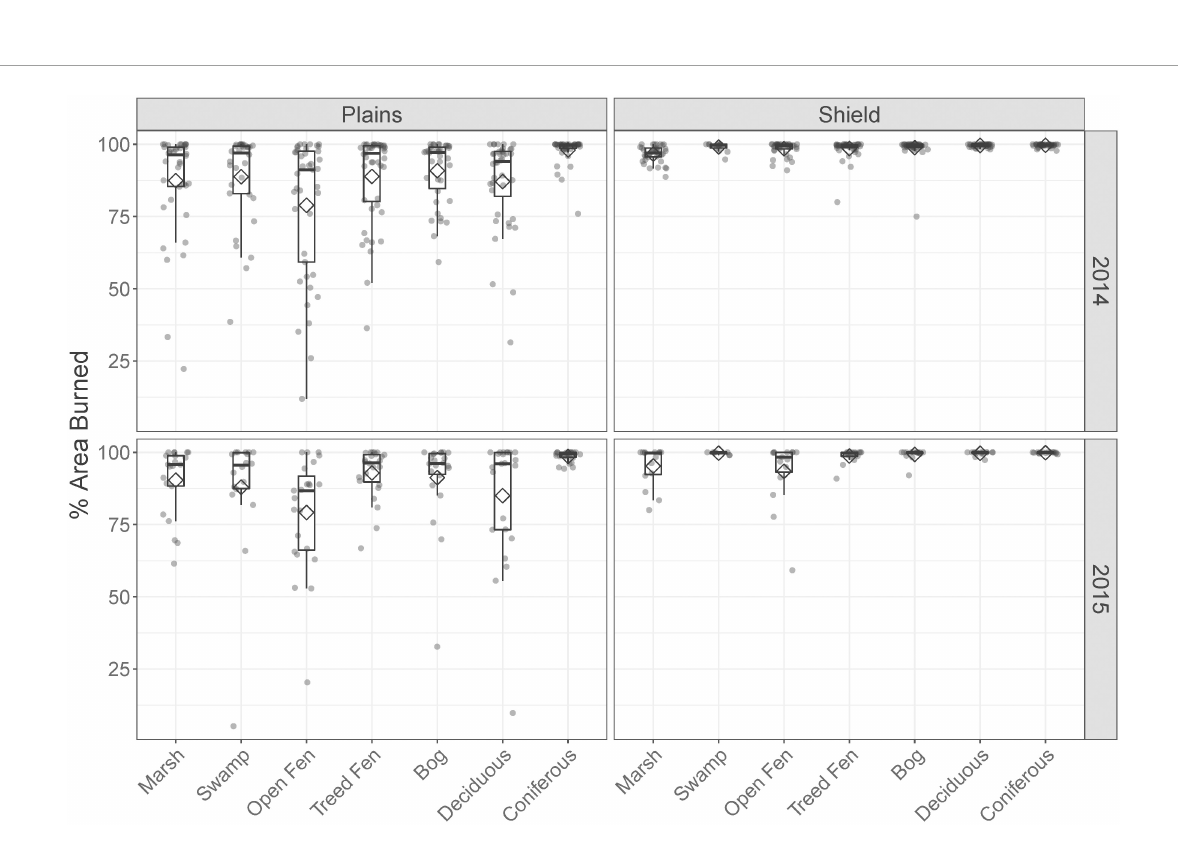
Frontiers in Forests and Global Change